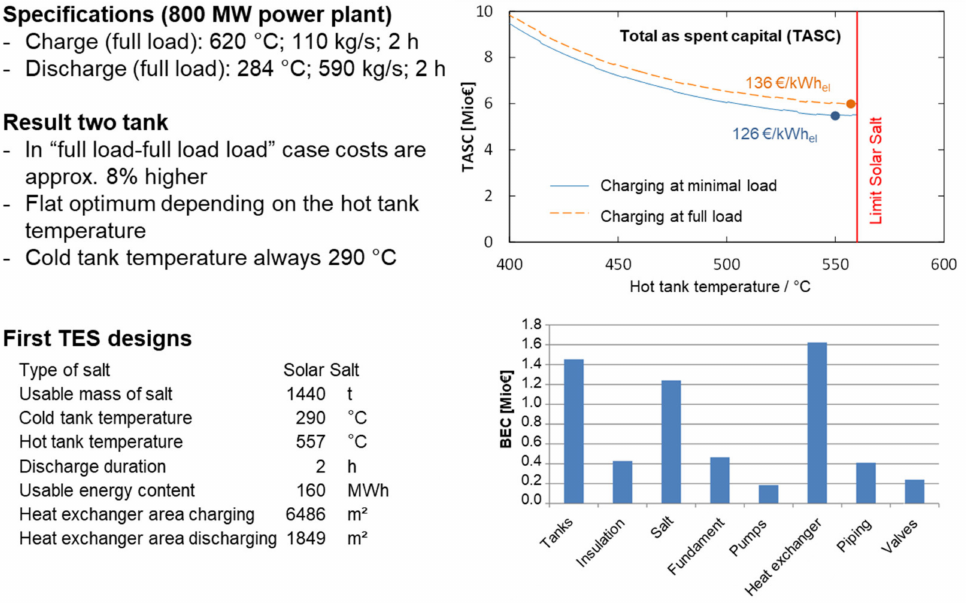
Figure 12. Detailed variation calculations for the storage option “molten salt” (concept HRH-